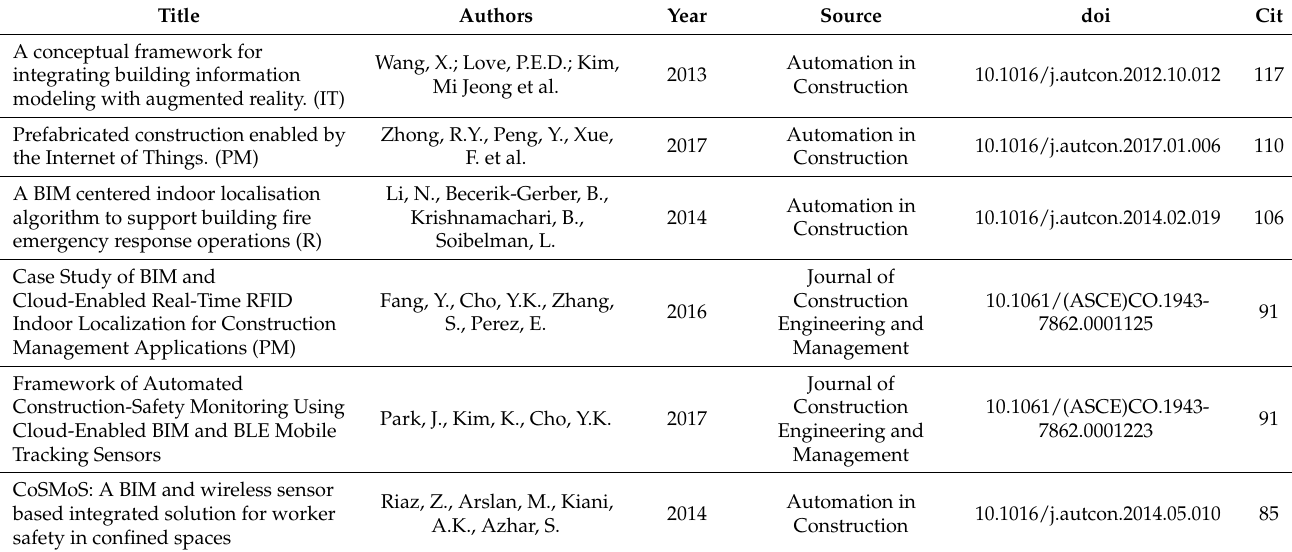
Table 7. Top 10 of the most cited articles sorted by the number of global citations (until February